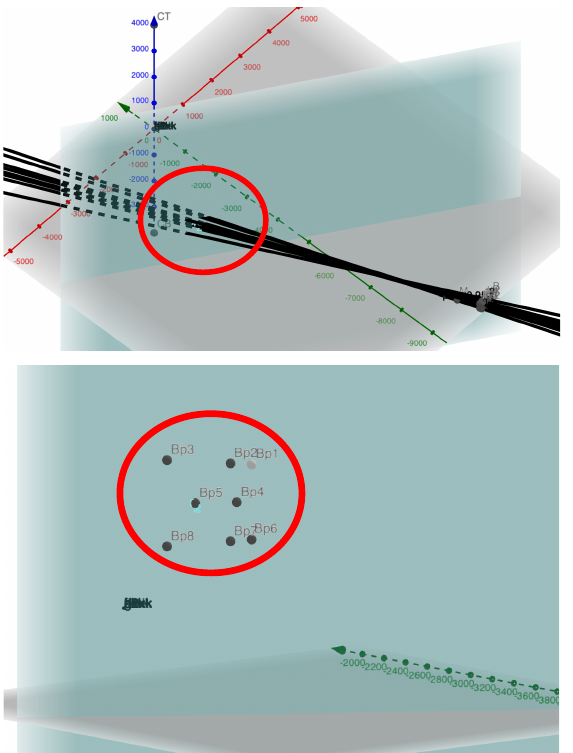
Fig. 4 . Incident points of the 8 beams k vectors